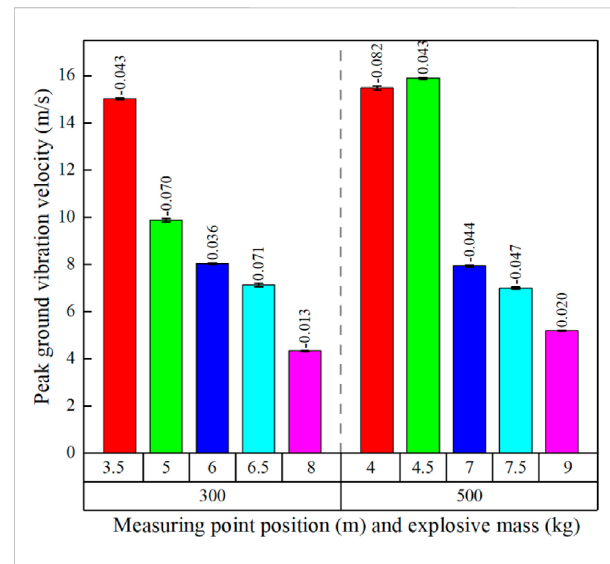
FIGURE 10 Measured data and calculated results relative error